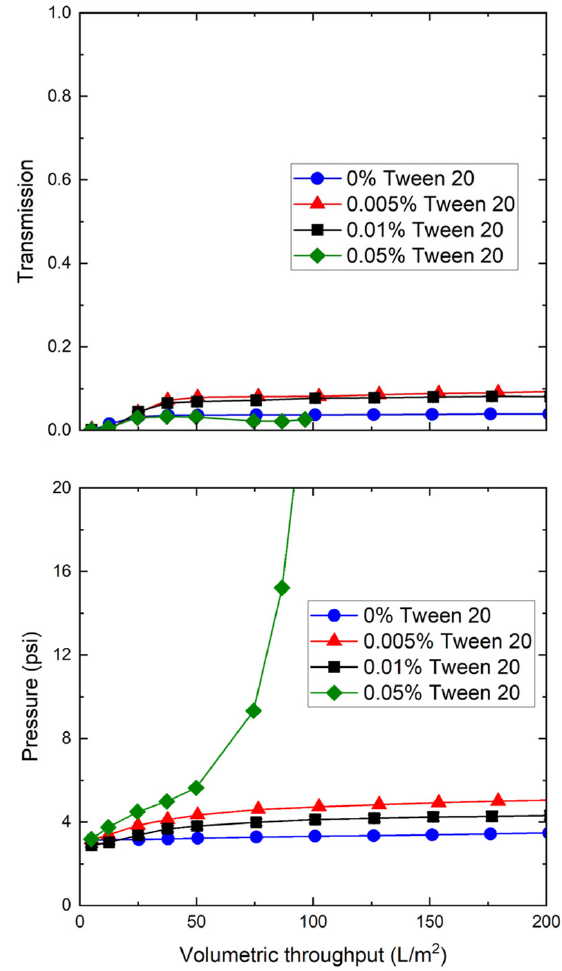
Figure 6. Effect of Tween 20 on nanoparticle transmission ( top panel ) and transmembrane pressure ( bottom panel ) during filtration of the 30 nm orange polystyrene nanoparticles through 0.1 µm mixed cellulose ester membranes at a constant filtrate flux of 150 LMH. Data obtained with suspensions having 3.4 × 10 12 particles/mL in 10 mM Tris buffer.